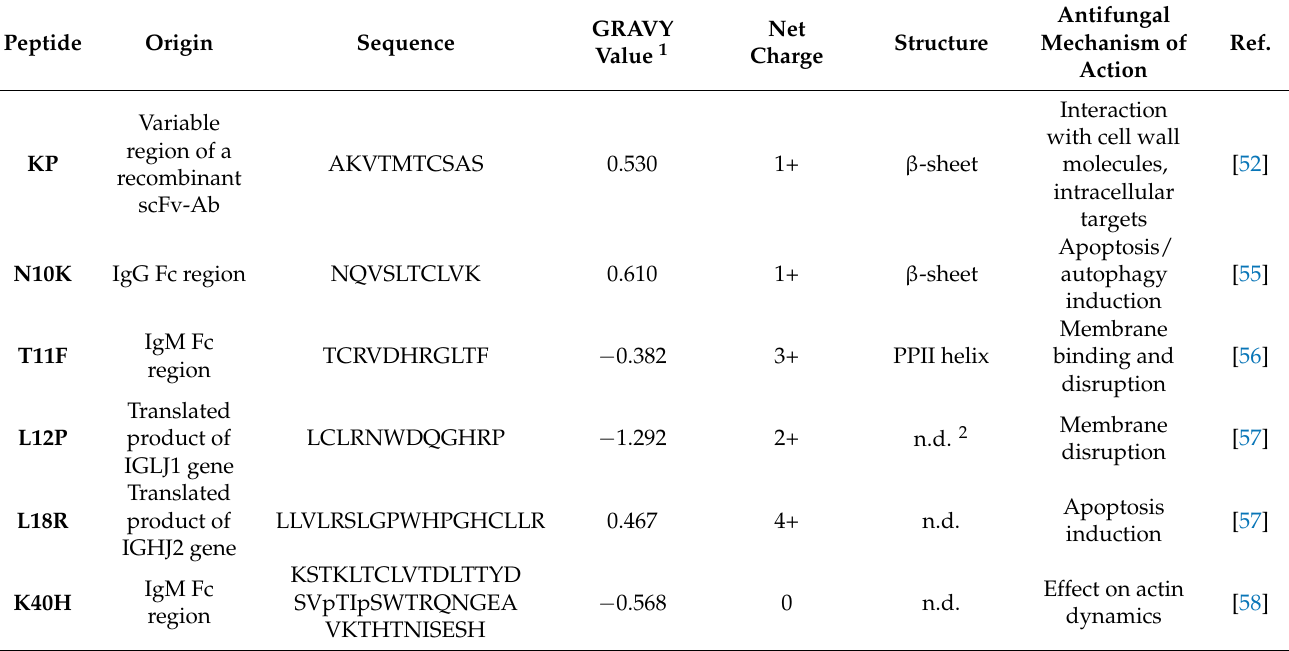
Table 1. Main features of the described antibody-derived